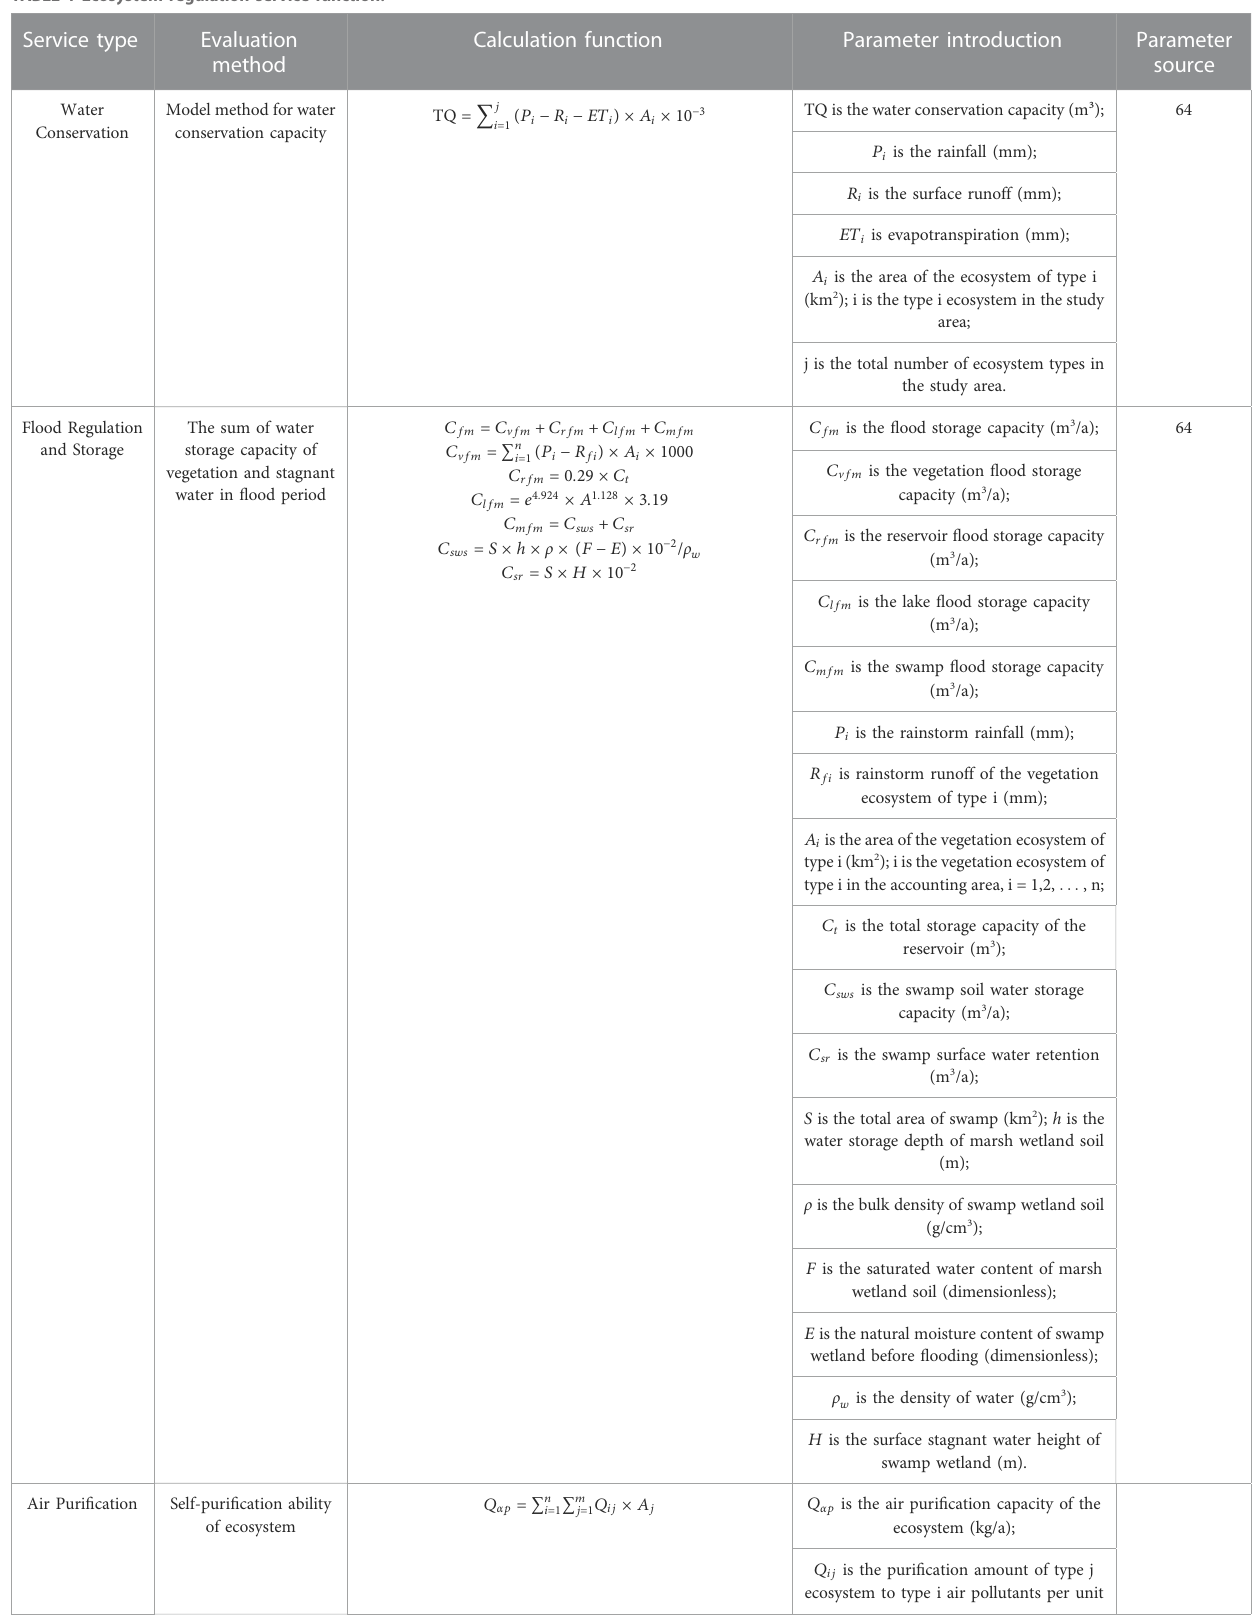
TABLE 1 Ecosystem regulation service